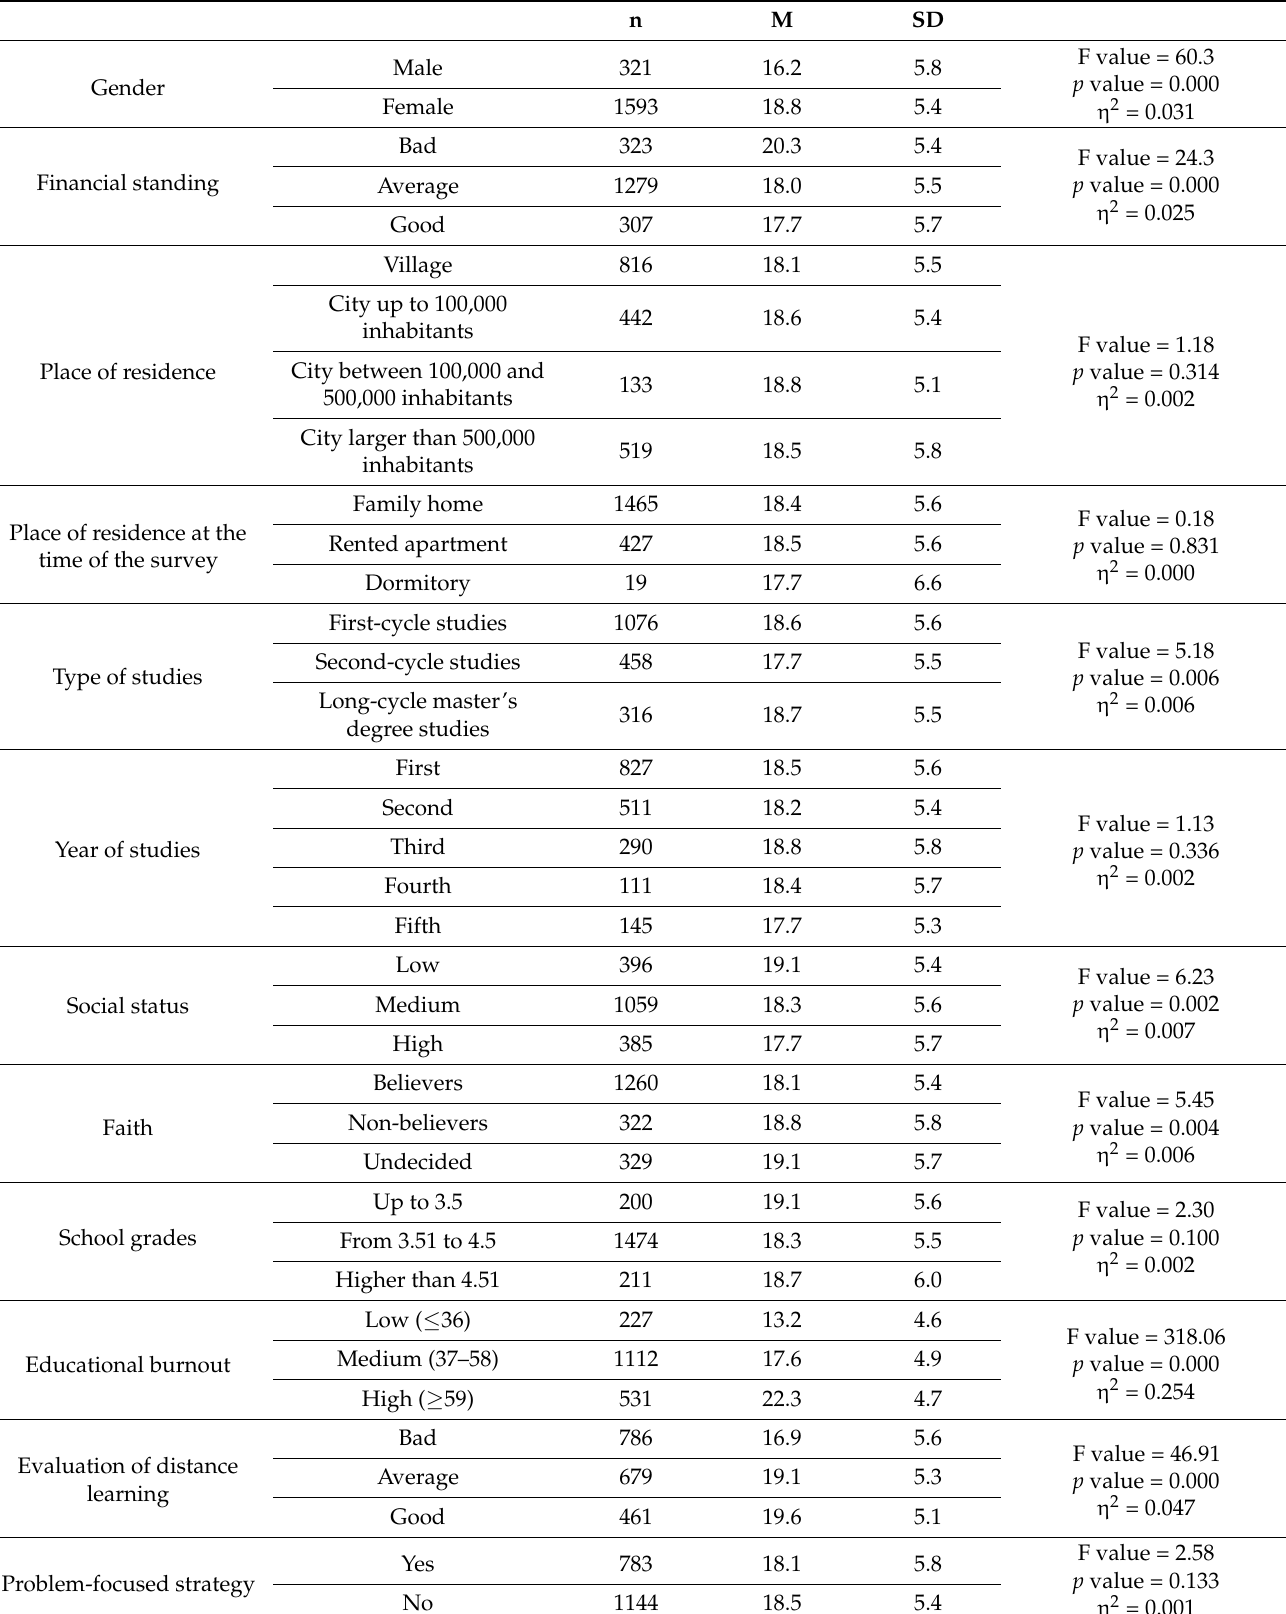
Table 1. Relationship between independent variables and mental